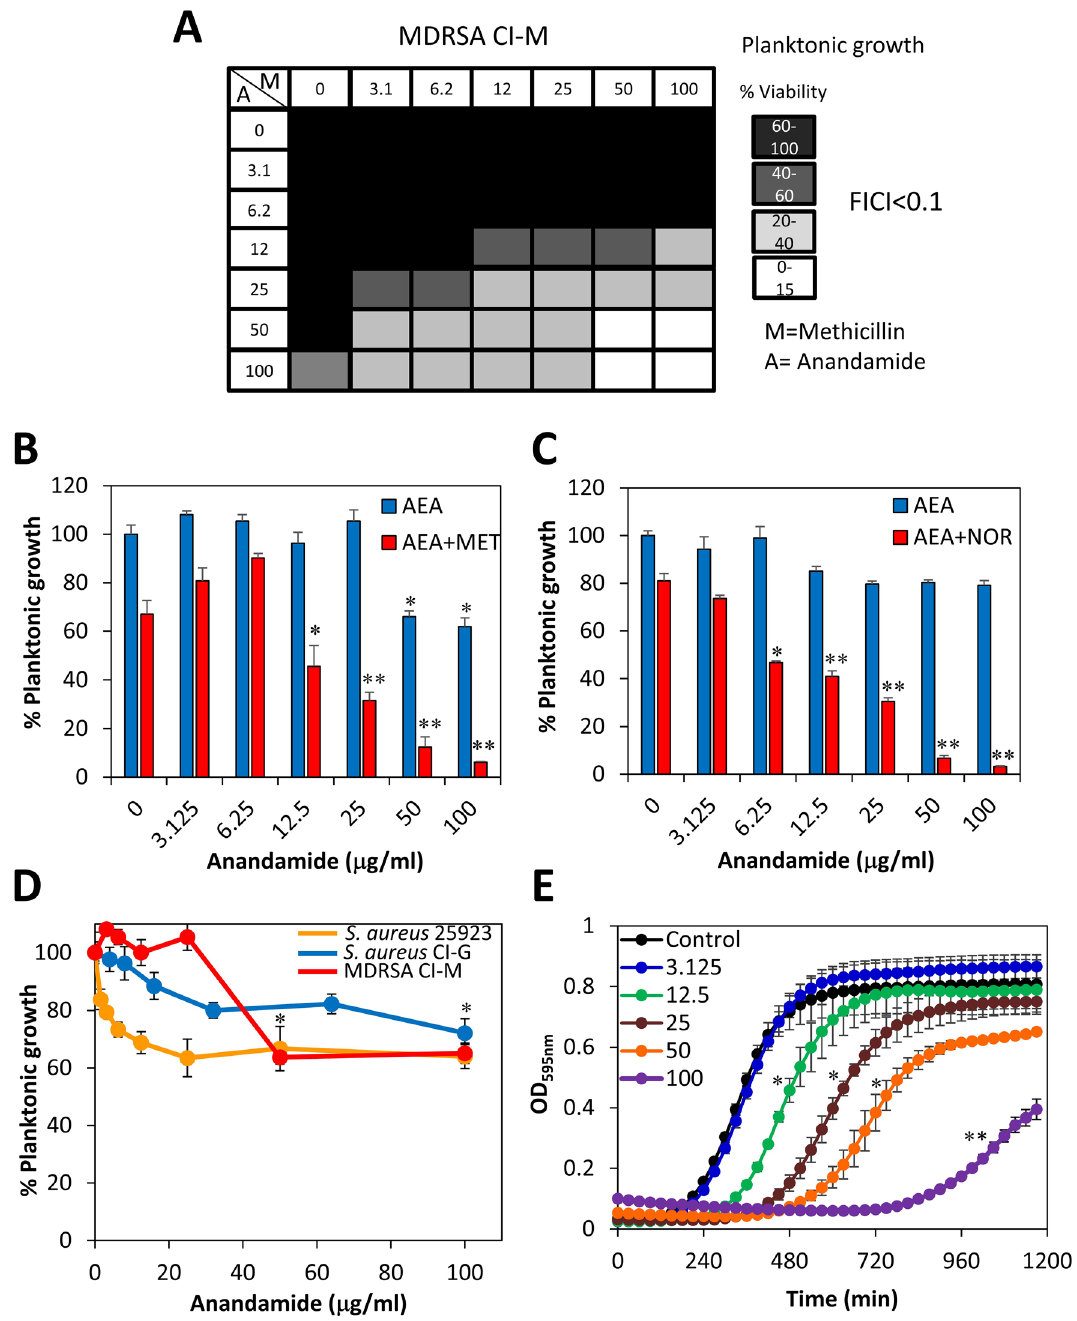
Figure 2. Anandamide (AEA) sensitizes MDRSA CI-M to methicillin and norfloxacin. ( A ) The survival of planktonic growing MDRSA CI-M after a 24 h incubation in a checkerboard assay of AEA with methicillin. A Anandamide; M Methicillin. ( B ) The survival of planktonic growing MDRSA CI-M in the absence or presence of 50 μg/ml methicillin (MET) and increasing concentrations of AEA. ( C ) The survival of planktonic growing MDRSA CI-M in the absence or presence of 50 μg/ml norfloxacin (NOR) and increasing concentrations of AEA. ( D ) The survival of planktonic growing MDRSA CI-M in the presence of increasing concentrations of AEA alone. ( E ) A kinetic study of the planktonic growth of MDRSA CI-M in the presence of increasing concentrations of AEA. *p < 0.05; **p <